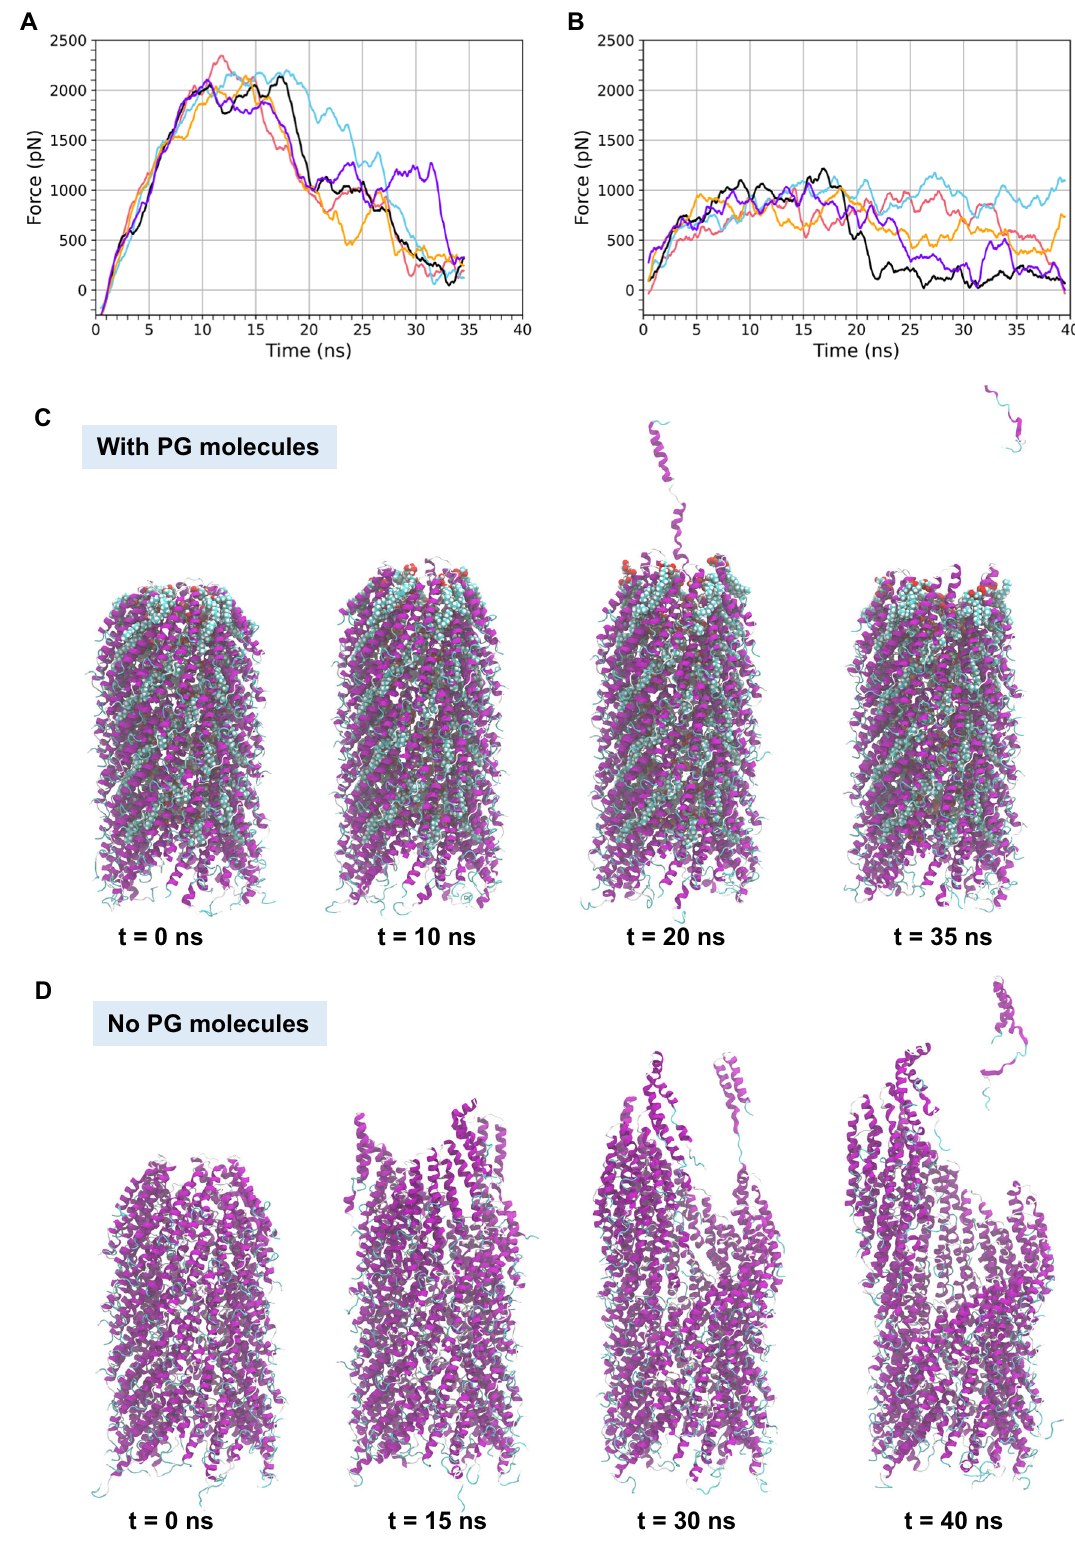
Fig. 4 | The F-pilus force response depends on the presence of phospholipids. Force versus time curves are shown for A the F-pilus simulations with phospholi- pids for each of the fi ve runs (run 1 — red, run 2 — blue, run 3 — black, run 4 — orange, and run 5 — purple) and B the F-pilus simulations without phospholipids. Four representativesnapshotsfromasteeredMDsimulation(run1)areshownfortheF-